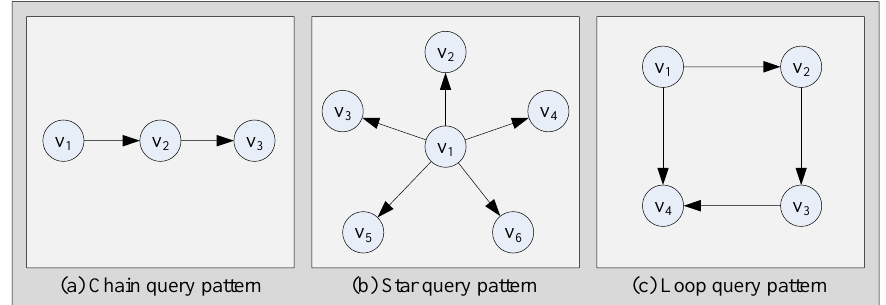
Figure 9. Query pattern graph.